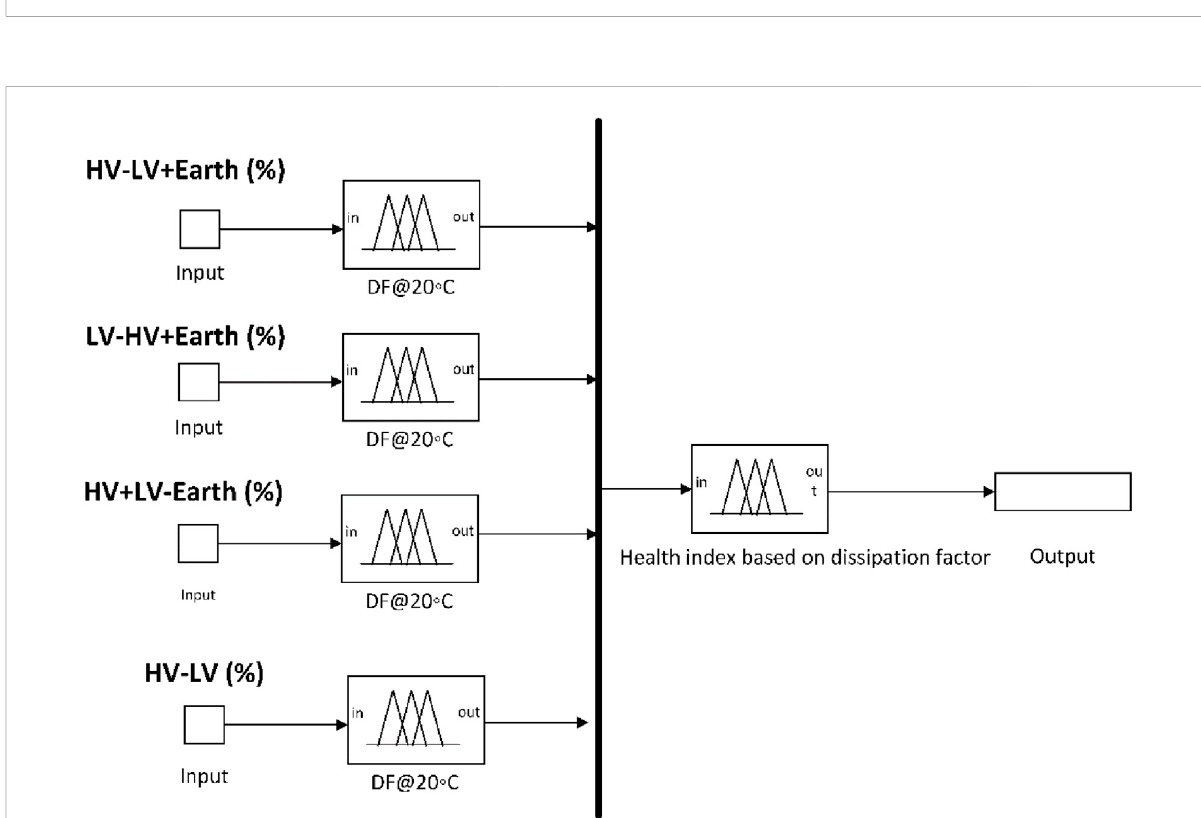
FIGURE 13 Fuzzy sublogic based on dissipation factor of the insulation